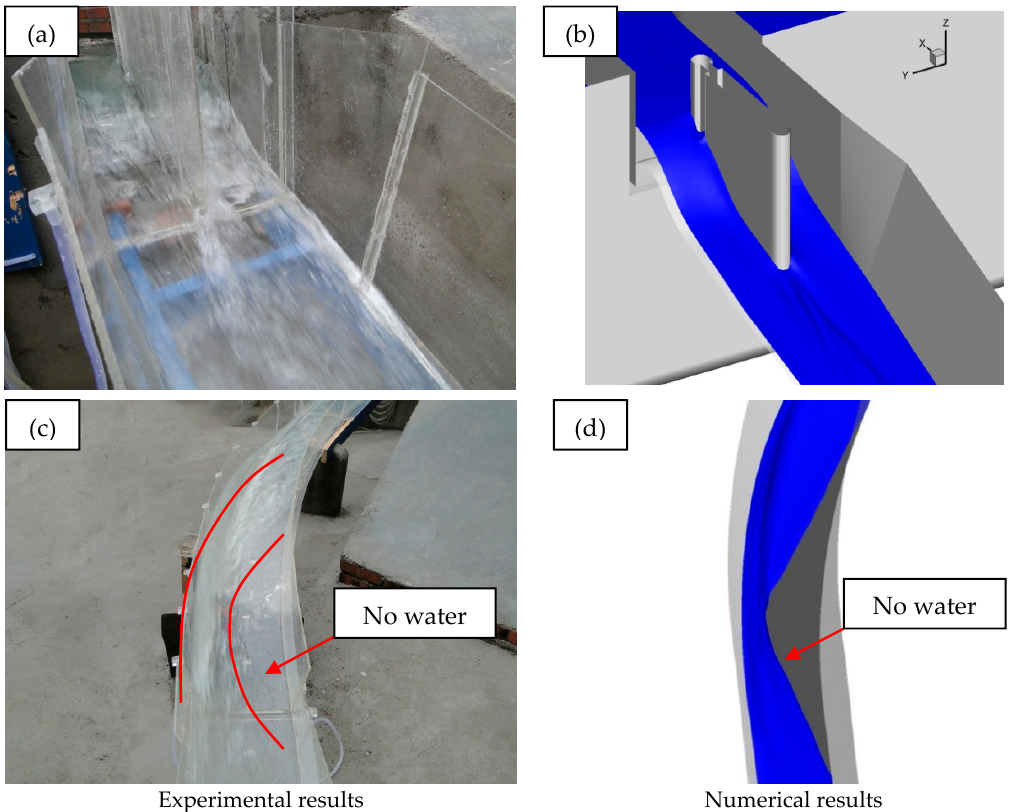
3.5 , z (cid:2868) = 5.0 , and z (cid:2868) = 7.5 .